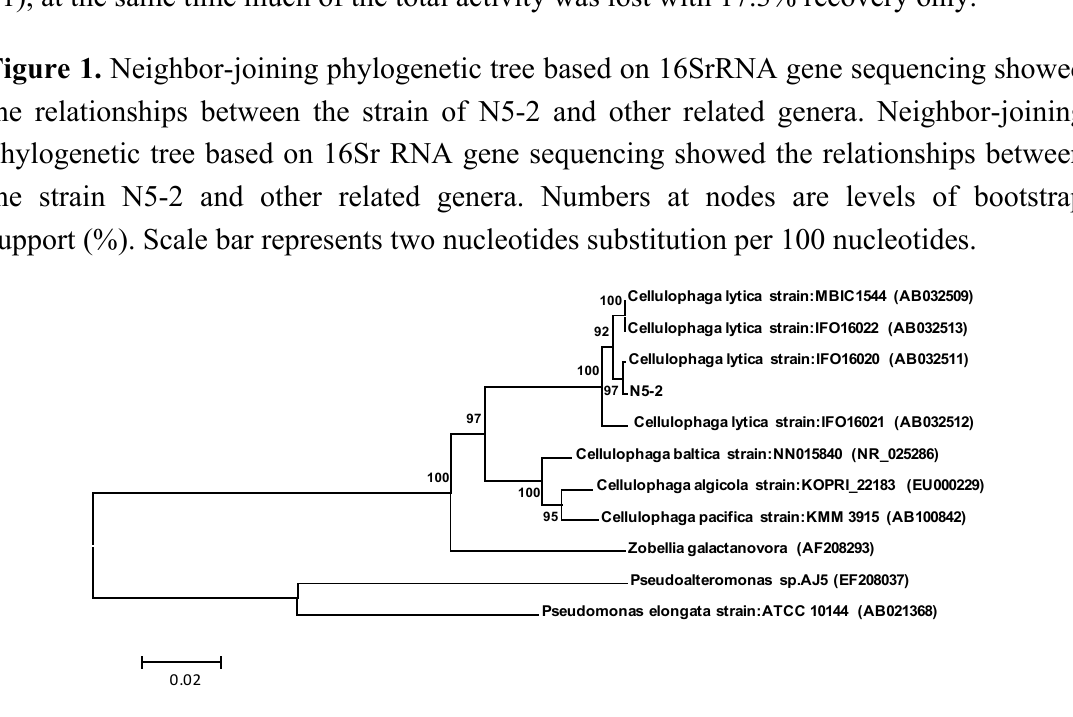
Figure 2. Gel filtration chromatography of κ-carrageenase. ( A ) Sephadex G-200 gel filtration chromatography; and ( B ) Sephadex G-75 gel filtration chromatography. The sample was eluted at a flow rate of 0.1 mL/min with Tris-HCl buffer at pH 7.0. The eluates were monitored for protein (A280) and κ-carrageenase